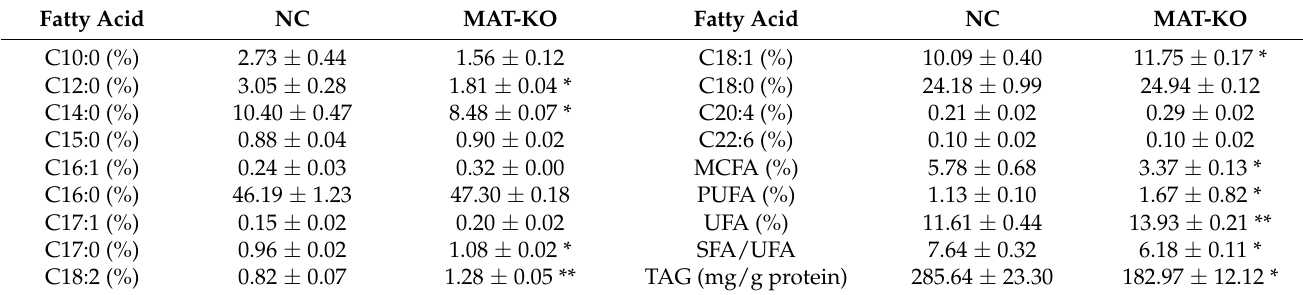
Fatty acid data are shown as ratio of the total fatty acids (%). Statistical analysis was performed with Student’s t test. MCFA—medium-chain fatty acid; PUFA—polyunsaturated fatty acid; UFA—un- Table 1. Effects of MAT-knockout on fatty acid composition and triacylglycerol content in GMECs. saturated fatty acid; TAG—triacylglycerol. Values are presented as means ± SEM . * p < 0.05, ** p < 0.01.